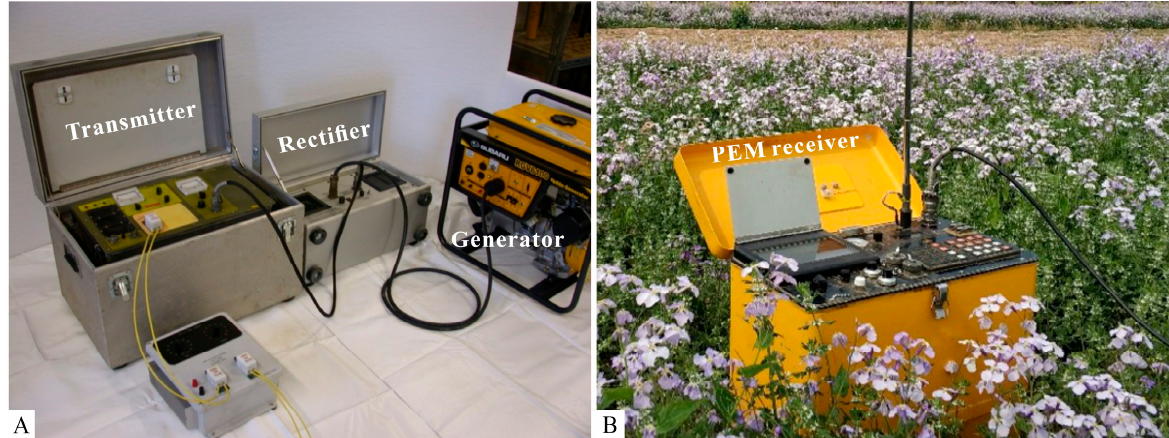
Figure 9. PEM system: ( A ) the transmitting system; ( B ) the receiving system.